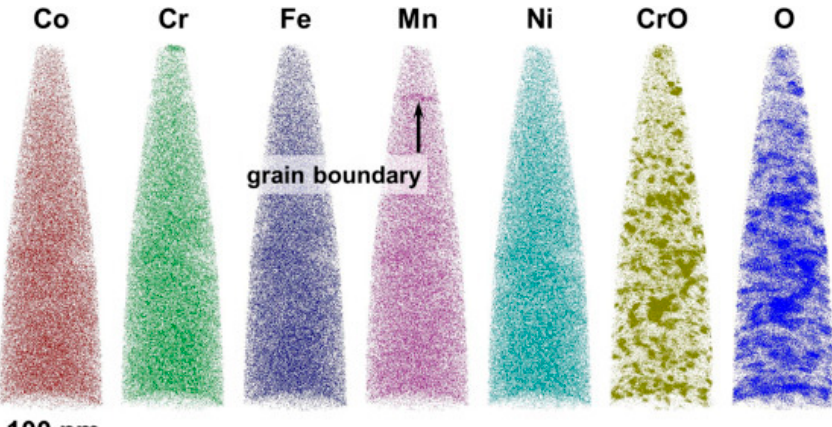
Figure 2. Distribution of elements examined by atom probe tomography in high-entropy alloy, CoCrFeMnNi, synthesized by high-pressure torsion, reproduced from [64], with permission from ELSEVIER, 2019.